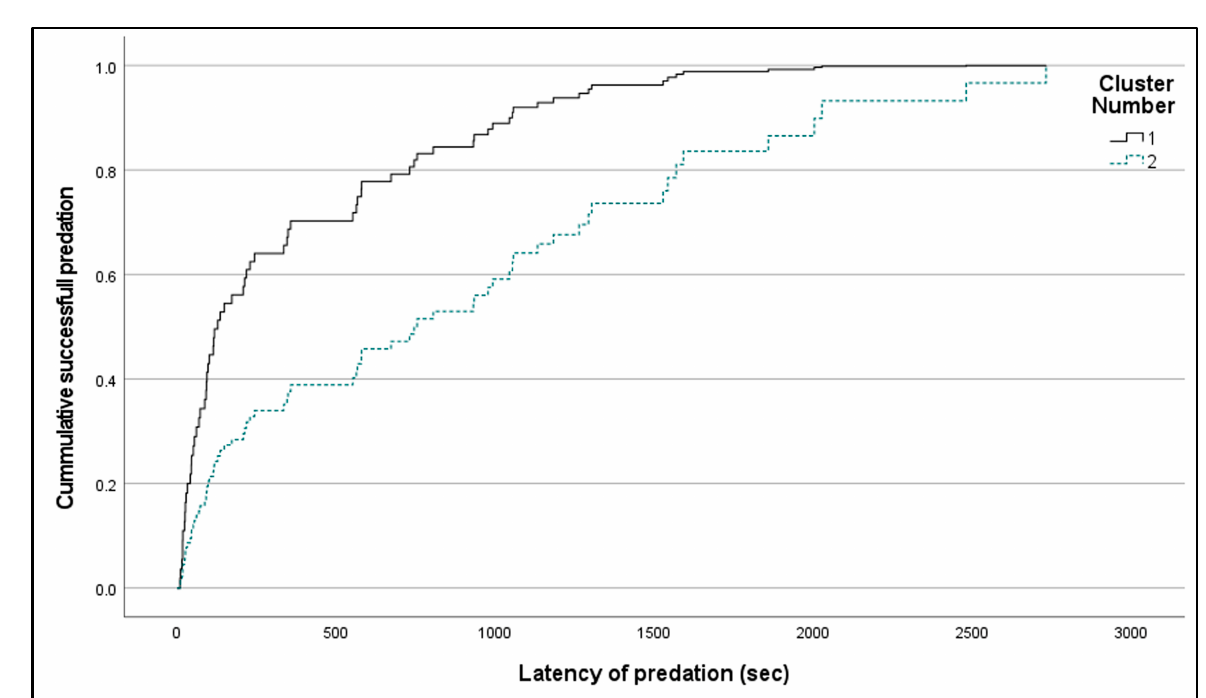
Figure 2. Cumulative event curves showing the effect of foraging clusters on the probability that fish had captured the prey before a given time during an experimental trial.